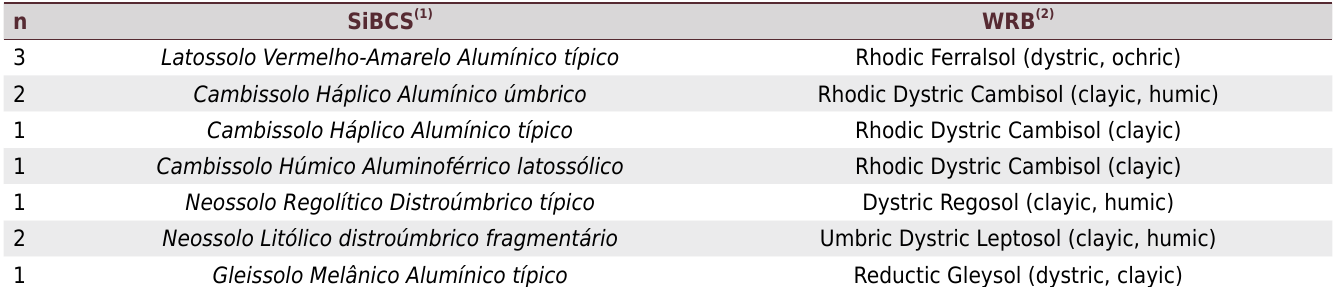
Table 1. Correlation between the Brazilian Soil Classification System and Word Reference Base used for soil dataset 1